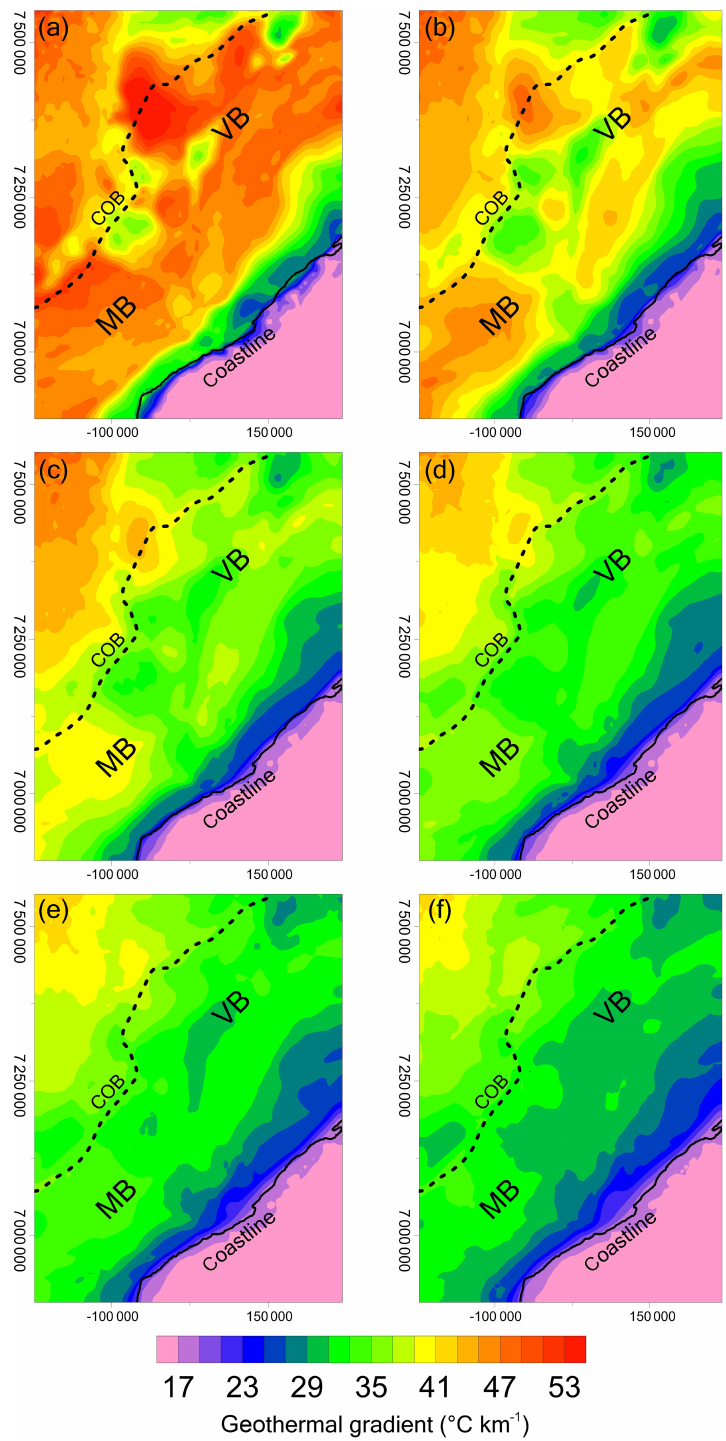
Figure 9. Geothermal gradient ( ◦ Ckm − 1 ) at the Norwegian margin: the gradient calculated as the temperature differences between the uppermost surface (upper thermal boundary) and the corresponding temperature distribution at (a) 1, (b) 2, (c) 3, (d) 4, (e) 5, and (f) 6km below the uppermost surface (COB: continent–ocean boundary; Cretaceous–Cenozoic basins: VB: Vøring Basin, MB: Møre Basin; UTM: WGS84,